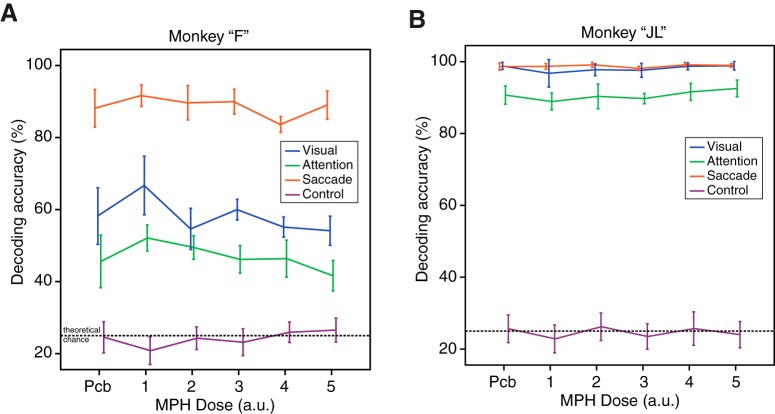
Effects of MPH on neuronal ensemble decoding of task-related information. A, Decoding accuracy of a SVM algorithm extracting single-trial information about the visual, attentional, and saccadic representations in the neuronal ensemble activity of simultaneously recorded neurons. Decoding accuracy, used as a proxy for neuronal coding accuracy, is presented as a function of drug dose (x-axis), as in preceding figures. The purple line represents the achieved chance performance using permutation testing and overlaps roughly with the theoretical chance performance of 25%. B, Same as A but for monkey “JL.” Error bars represent SEM.